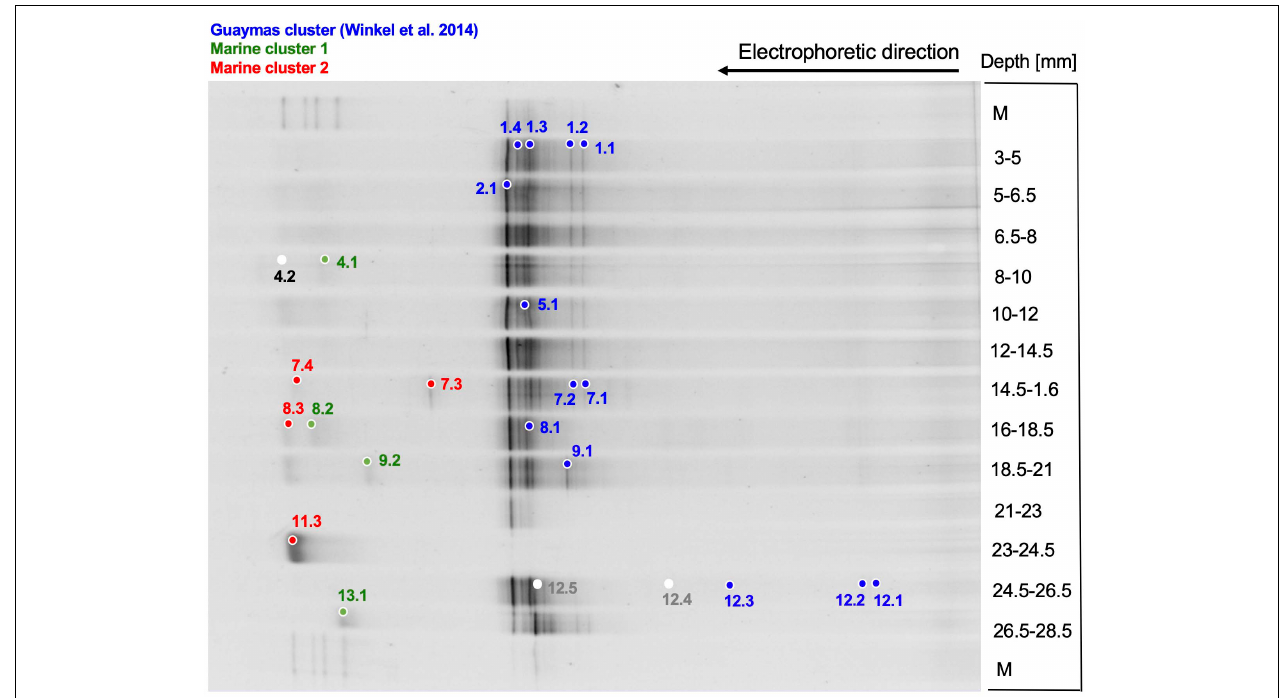
FIGURE 6 | DGGE analysis of bacterial ammonia monooxygenase alpha subunit genes (amoA). DGGE bands are color-coded to match their phylogeny. The Guaymas cluster in blue was defined by Winkel et al. (2014). Marine clusters 1 and 2, highlighted in green and red, are defined in this